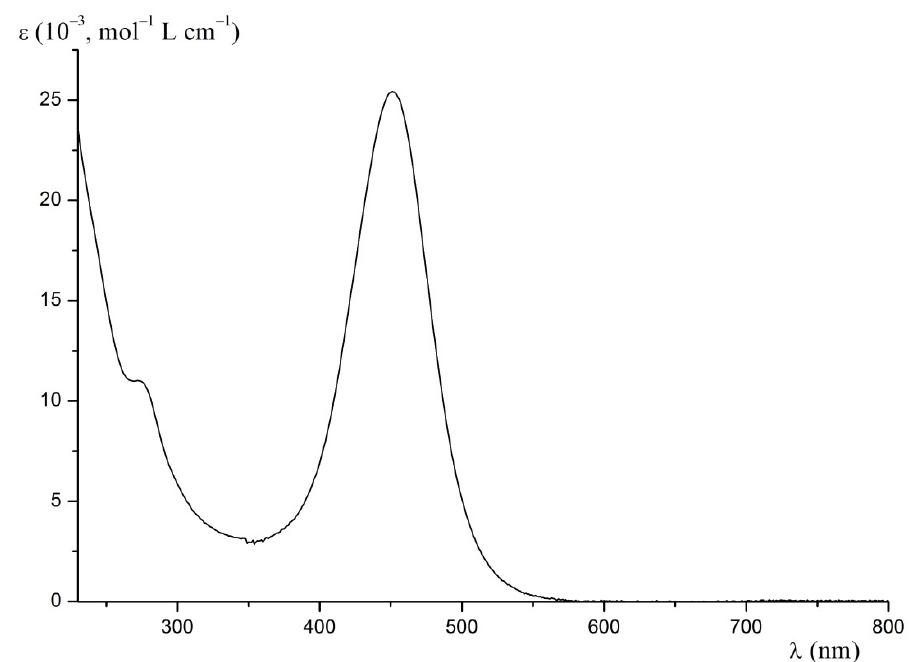
Figure 1. The solution UV-vis spectrum of the complex FeOx 3 (BCH 3 ) 2 ( 5 ) in dichloromethane at its concentration equal to 2.1 × 10 − 4 mol L − 1 .